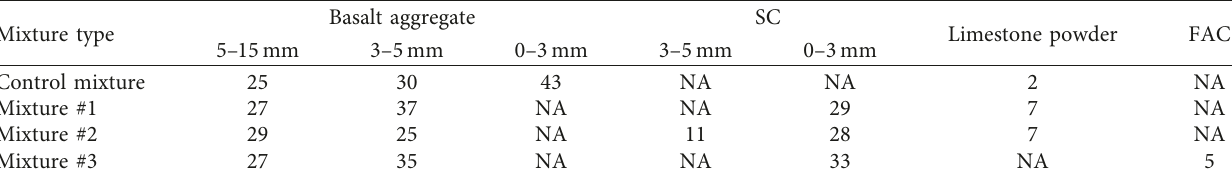
Figure 2: Representative morphology images of lightweight aggregate: (a) SC with particle size of 3–5mm; (b) FAC. Table 1: Mass ratios of the aggregate and filler in AC-13 asphalt mixture (wt.%).